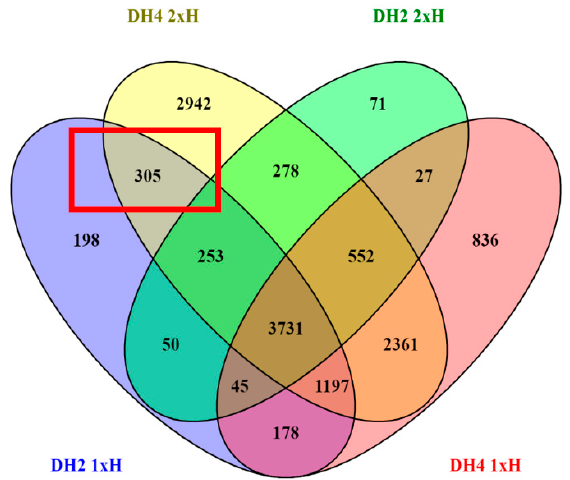
Figure 9. Venn diagram displaying common and specific DEGs regulated under 1xH and 2xH treatment in comparison to control conditions.